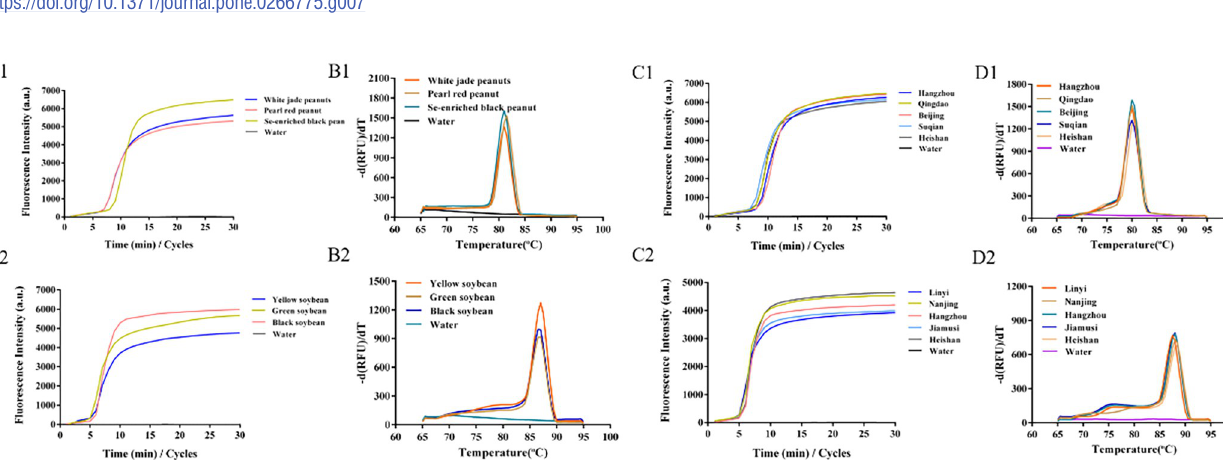
PLOS ONE | https://doi.org/10.1371/journal.pone.0266775 December12, 2022 12 /